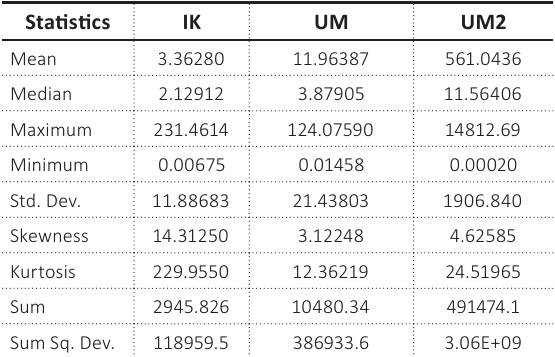
Table 1. Descriptive statistics of variables